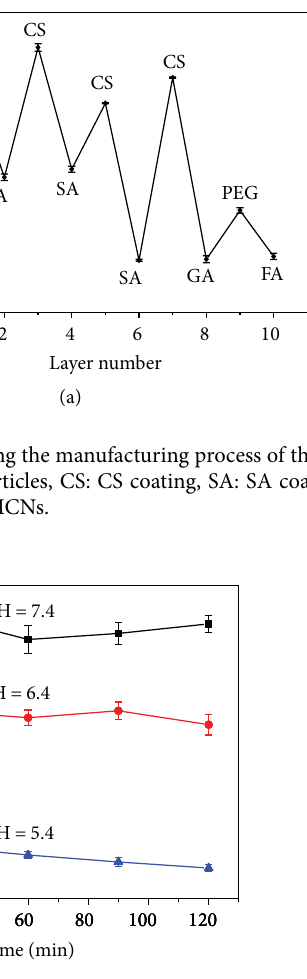
Figure 3: Time-dependent DLS-measurements of MCNS in PBS with different pH values (5.4, 6.4, and